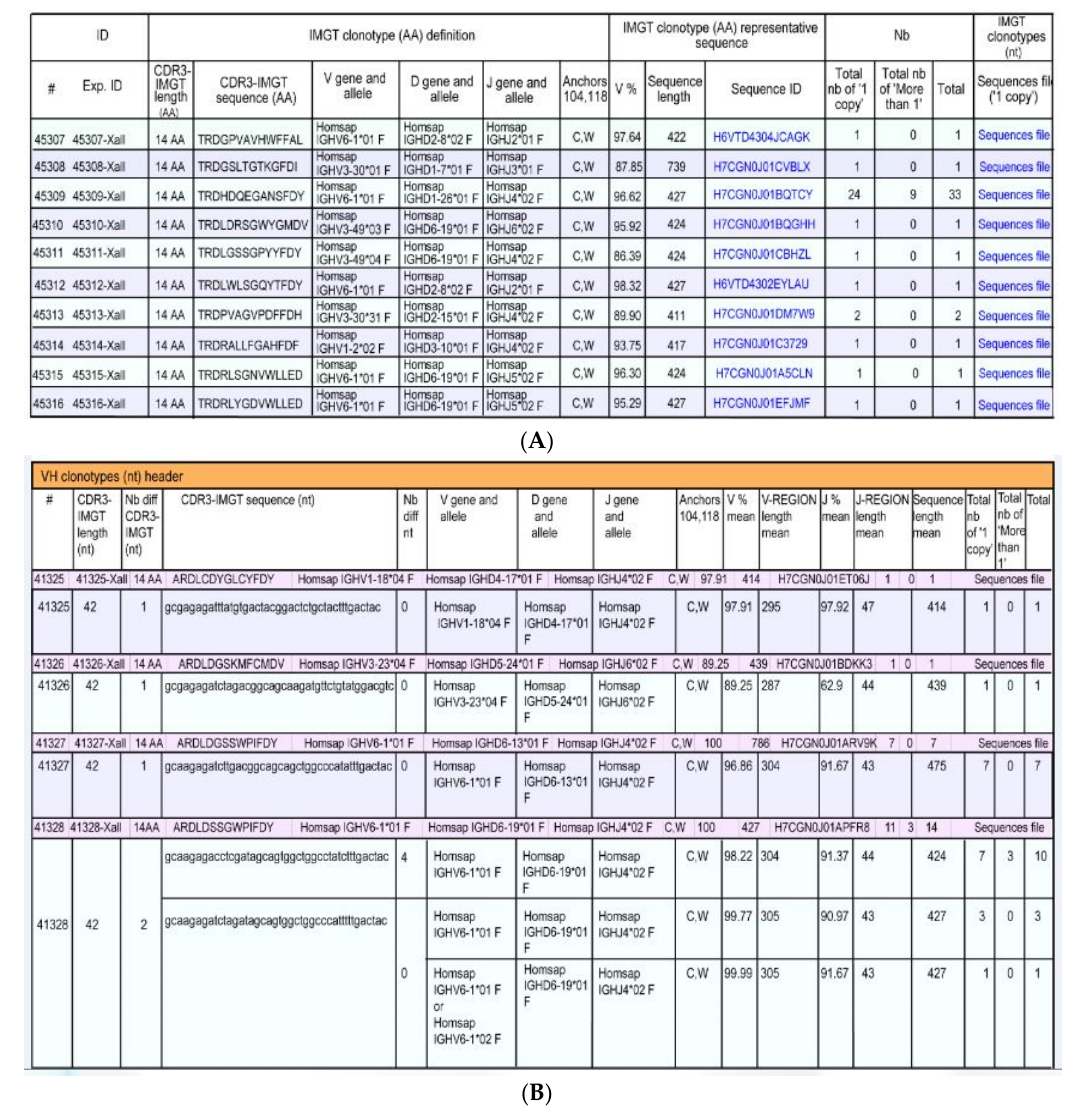
Figure 27. Displays of ( A ) IMGT clonotypes (AA) and ( B ) IMGT clonotypes (nt). IMGT clonotypes (AA) and (nt) are characterized by the IMGT / HighV-QUEST statistical module [66,73]. Displays are based on CDR3-IMGT lengths. In B, the pink lines correspond to IMGT clonotypes (AA) with, below each one of them, the corresponding IMGT clonotypes (nt). (With permission from M-P. Lefranc and G. Lefranc, LIGM, Founders and Authors of IMGT ® , the international ImMunoGeneTics information system ® , http: //